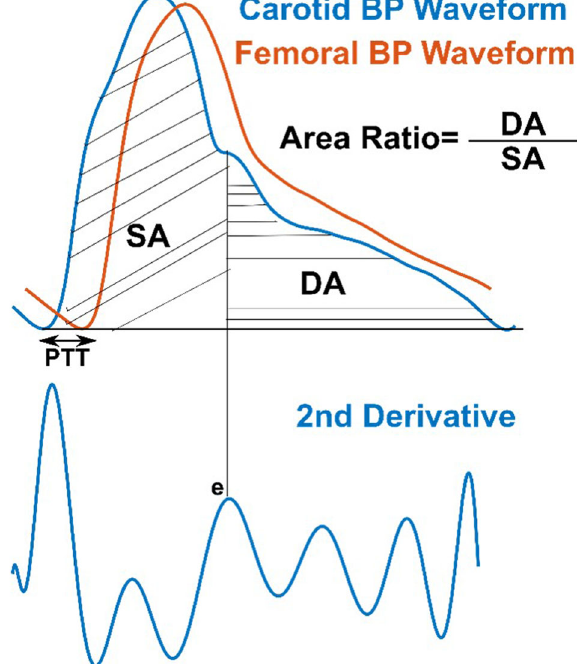
Fig. 4 Arterial waveform features selected as inputs to linear regression models for predicting the maximal aortic diameter